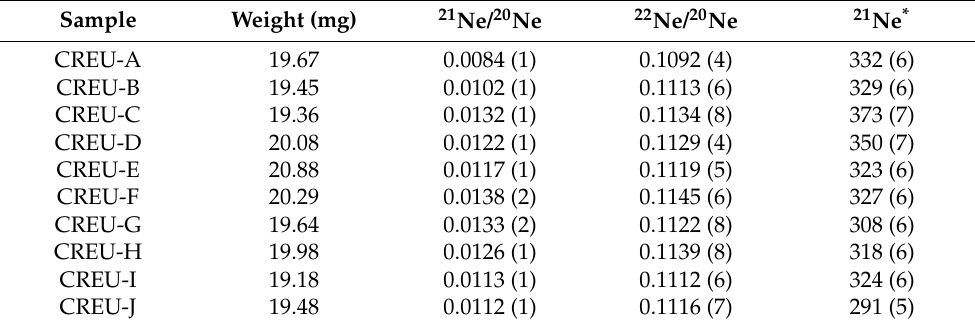
Table 2. Ne data of CREU quartz analysed using SUERC’s ARGUS VI mass spectrometer.